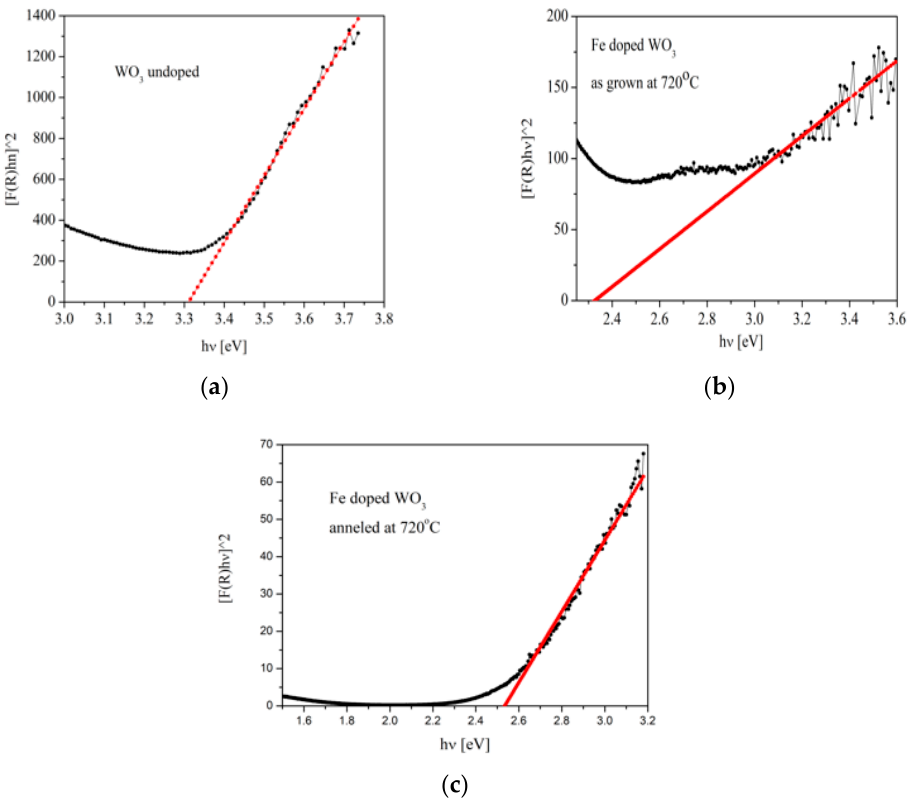
Figure 7. The Eg for WO 3 film and Fe-doped WO 3 film samples. ( a ) WO 3 film grown at 600 °C (undoped); ( b ) Fe-doped WO 3 as-grown at 720 °C; ( c ) Fe-doped WO 3 annealed at 720 °C.